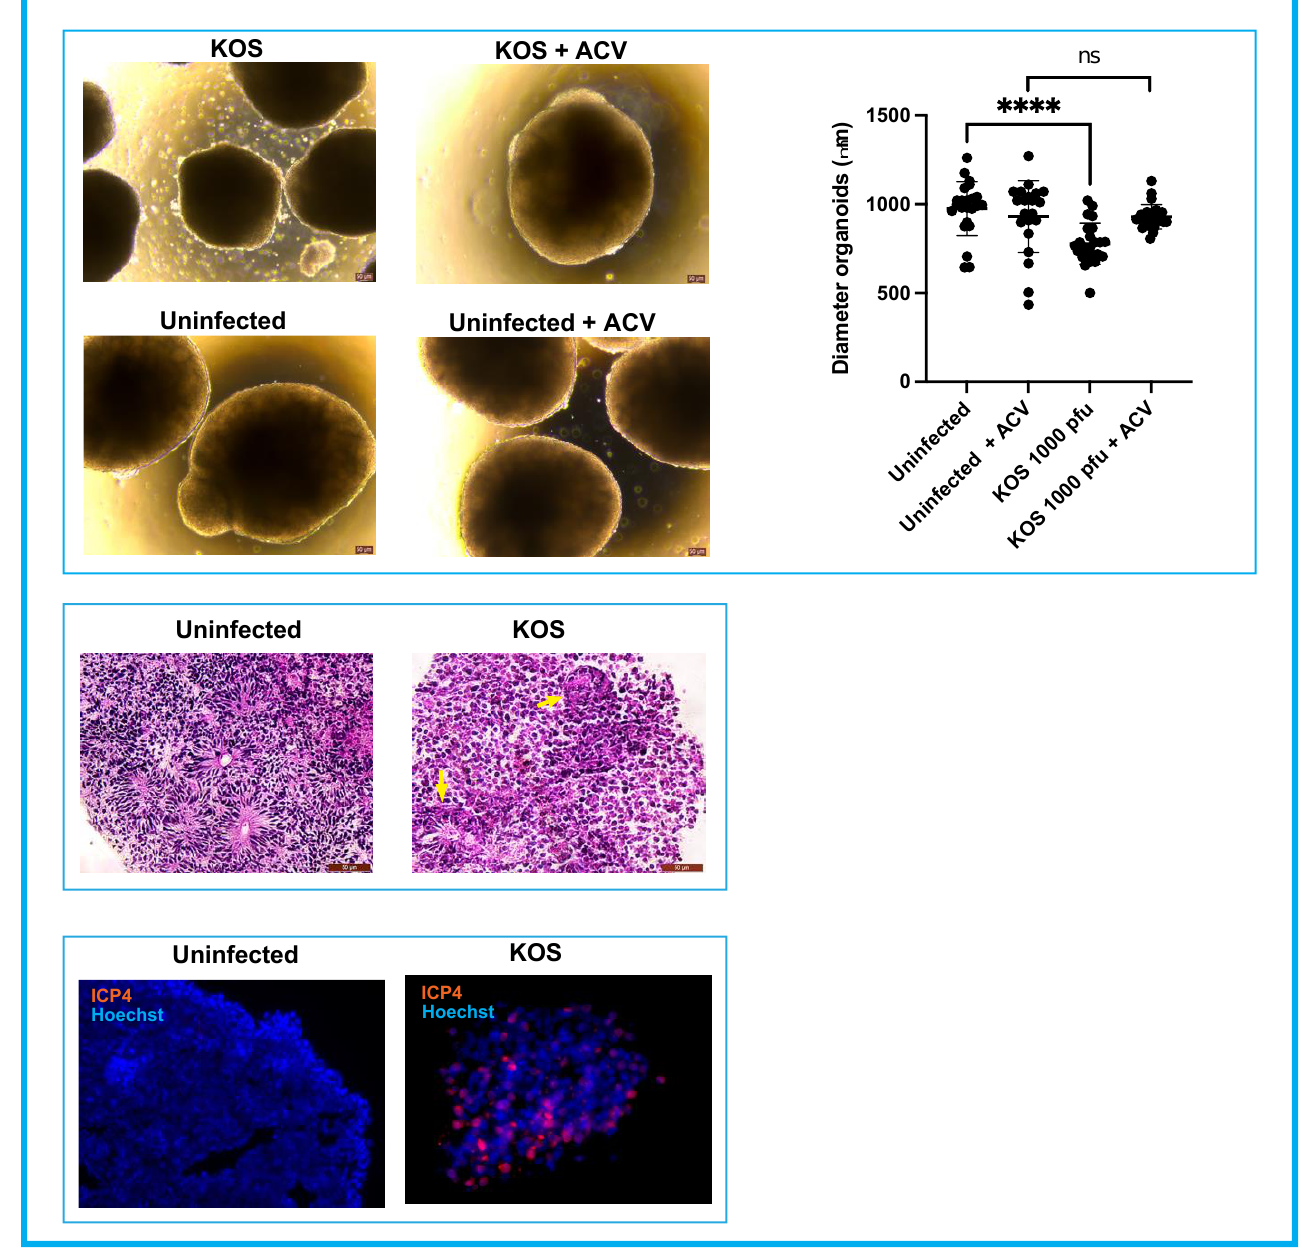
Figure 3. Analysis of infected organoids on day 4 p.i . Top panel: The infected cultures in the absence of ACV were significantly smaller when compared to the organoids in other conditions (Student’s t tests: **** p < 0.0001). Also, cells started detaching from the surface of these organoids indicating an initial loss of tissue integrity. Conversely, infected organoids cultured in the presence of ACV where comparable in terms of size and tissue integrity to the uninfected organoids exposed or not to ACV. Middle panel : Neural rosettes lost their typical organization in productively infected organoids, suggesting that the productive infection interferes with normal development of these structures. Examples of disorganized rosettes in infected organoids are indicated by yellow arrows. The expression of the viral antigen ICP4 is shown in the bottom panel .